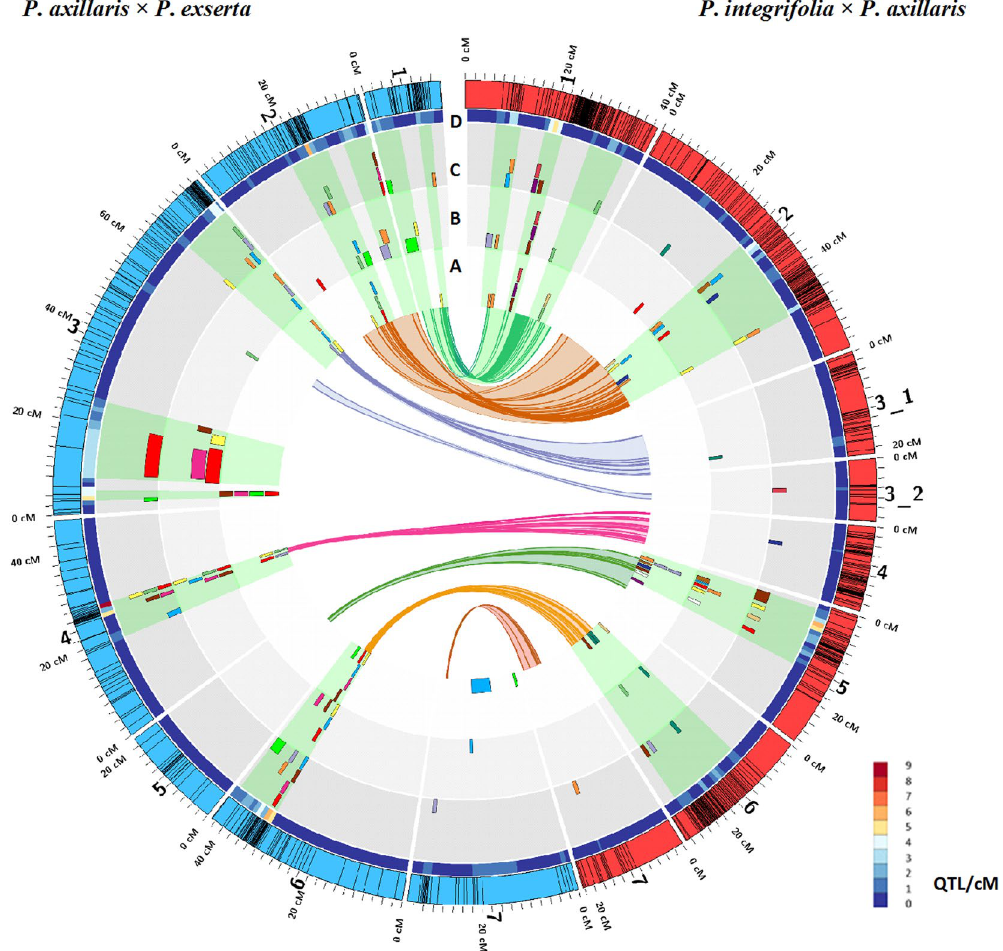
Figure 2. Overall QTL summary for P . integrifolia × P . axillaris (IA) and P . axillaris × P . exserta (AE) populations. Rings represent QTL detected at 14 °C ( A ), 17 °C ( B ), and 20 °C ( C ). Each color represents a different trait, and areas highlighted in green represent QTL rich regions. ( D ) Heat map showing the overall QTL density across each linkage